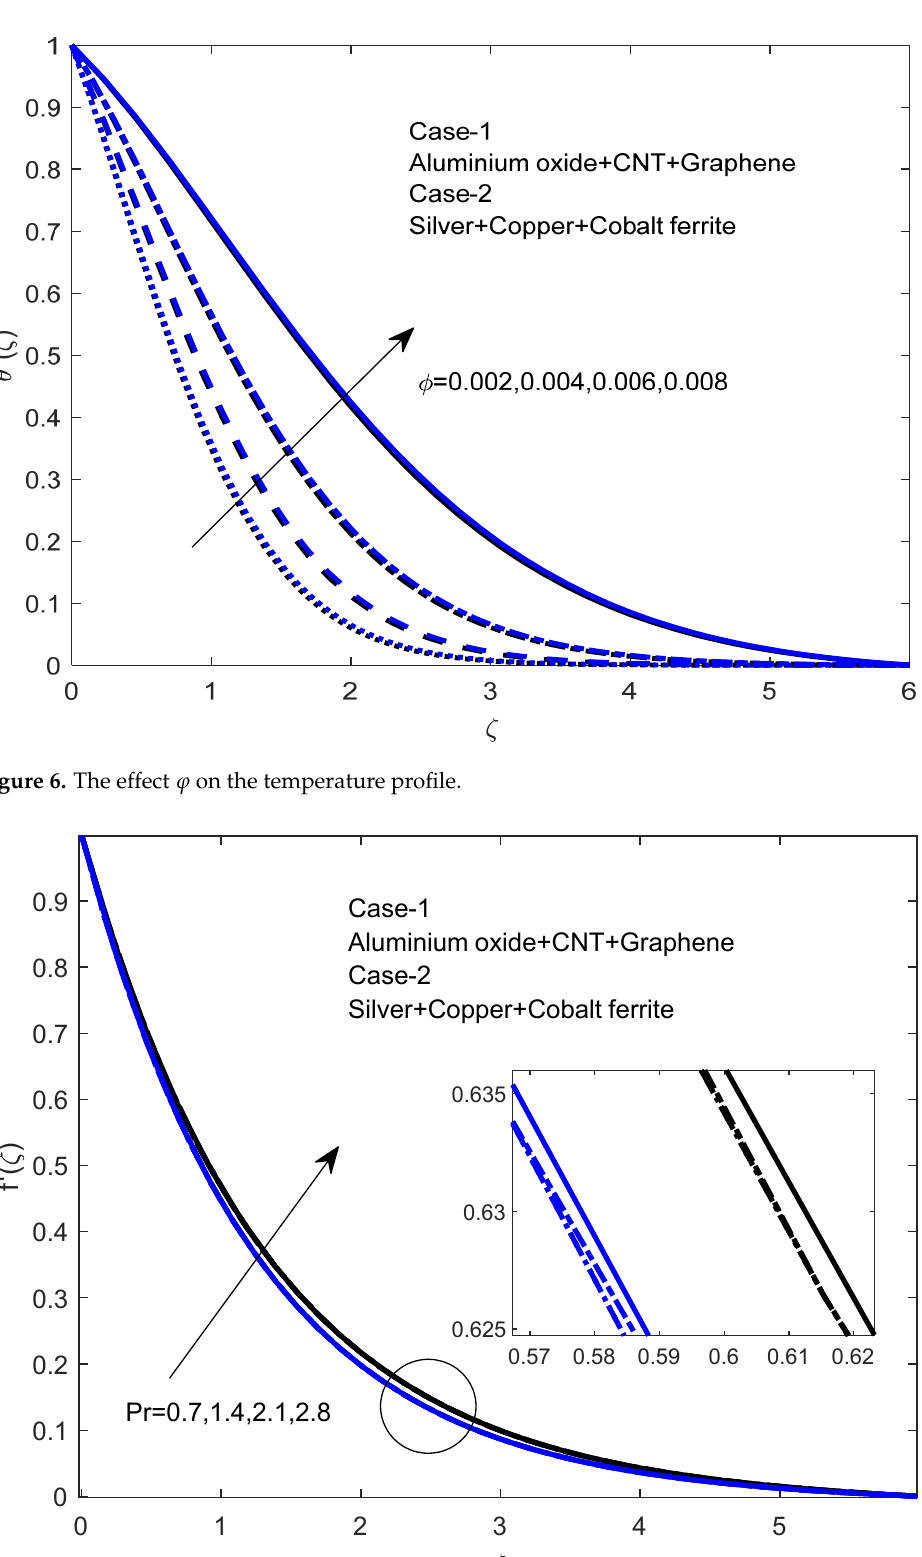
Figure 7. The effect of Pr on the velocity profile.